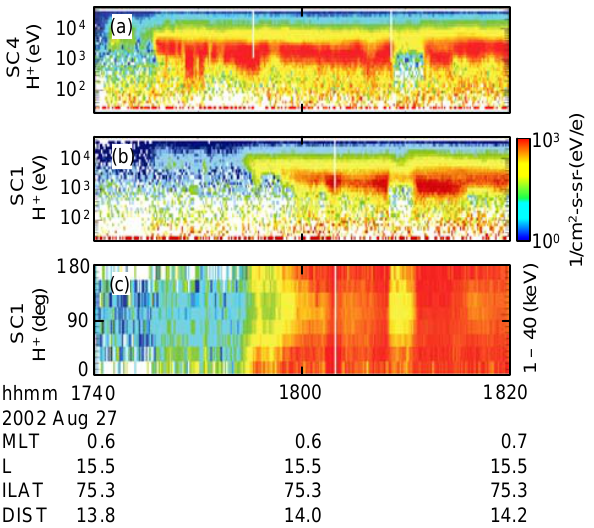
Fig. 3. (a) Expanded portion of Figure 2a on August 27. (b) Simultaneous proton flux at SC1. (c) Pitch-angle distribution of SC1 flux above 1 keV. Ephemeris is that of SC1 (see Table 1 for separations). vertical edges. As shown in Table 1 (top), SC1 is earthward